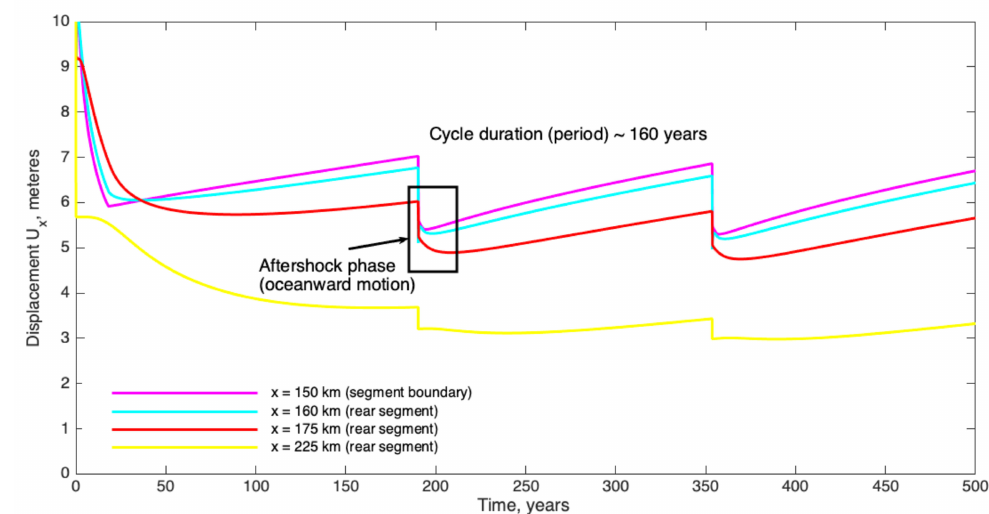
Figure 10. Displacement variations W ( x , t ), simulated with a two-segment model for a series of points within the rear-segment blocks ( x = 150, 160, 175, and 225 km), calculated for a typical set of model parameters (see Table